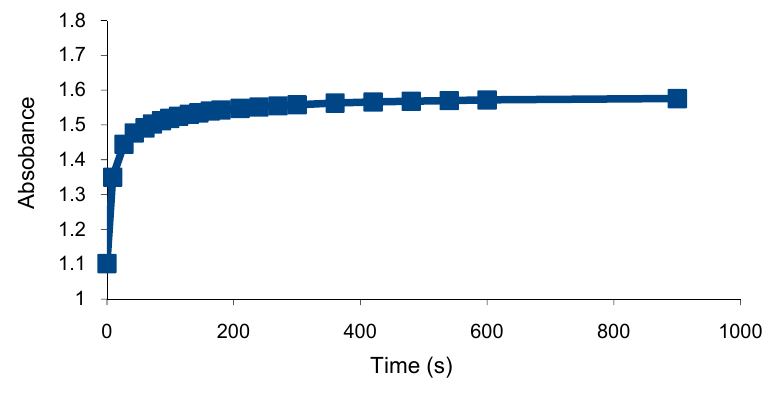
Figure 7. Response time of the sensing element towards Hg 2+